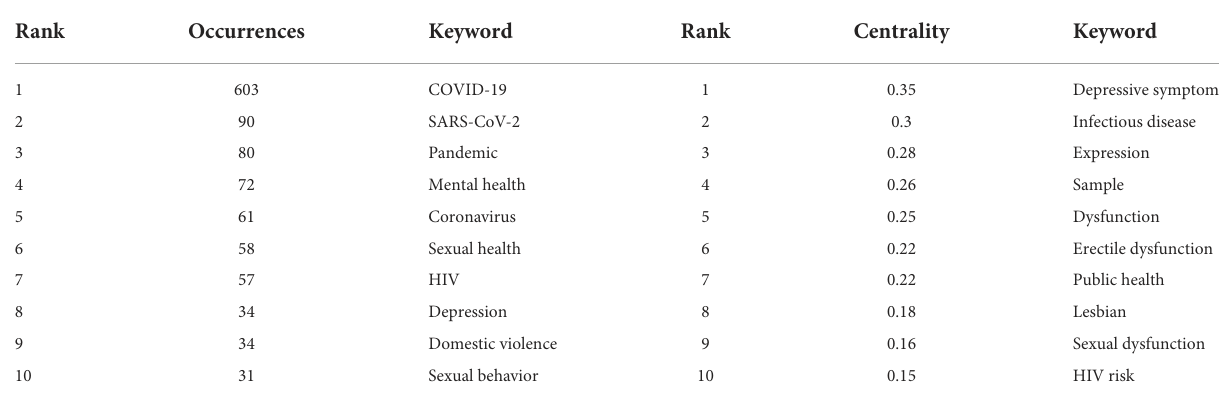
TABLE 6 Top 10 keywords by the occurrences and